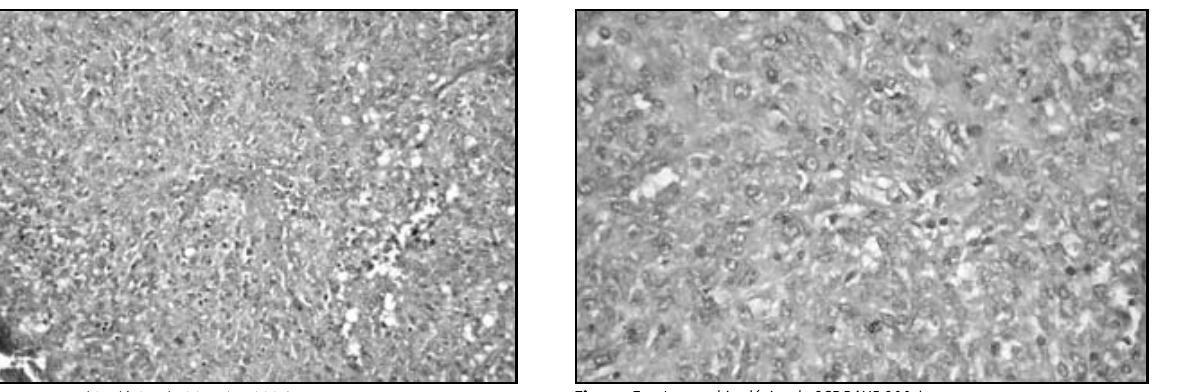
Figura 4 – Aspecto histológico do SCDF (HE 100x) Figura 5 – Aspecto histológico do SCDF ( HE 200x)